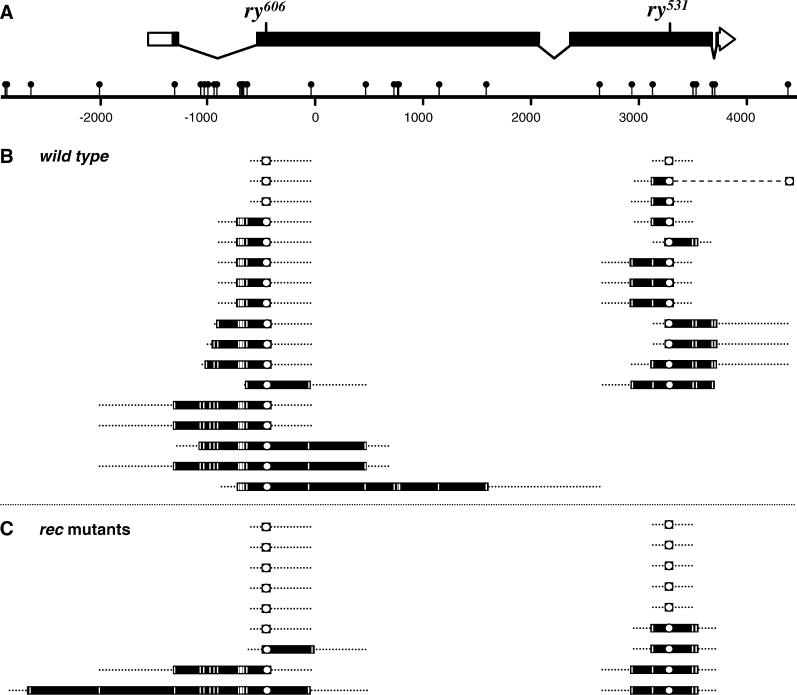
Gene Conversion Tracts from Wild-Type and rec Mutants(A) Schematic of the rosy locus. Intron/exon structure is shown, with coding sequences filled. The positions of the selected sites corresponding to the ry606 and ry531 mutations are shown. Heterologies between the ry606 and ry531 chromosomes are indicated as lollipops on the scale bar. These are all single nucleotide polymorphisms, except for −1029 and −685, which are insertions of one- and four-bp, respectively, in ry531 relative to ry606. The scale is in bp, using the coordinate system of Bender et al. [56].(B and C) Tract lengths observed in NCOs recovered from wild-type (B) and rec mutants (C). Each bar represents an independent event, with the open circle denoting the selected marker (ry606 or ry531 mutant sites). Black bars represent the minimum tract length for each event, with co-converted sites marked by white lines. Dotted lines represent the maximum tract length possible based on the next unconverted polymorphism. The dashed line in the second ry531 conversion on panel B indicates a possible discontinuous conversion tract.